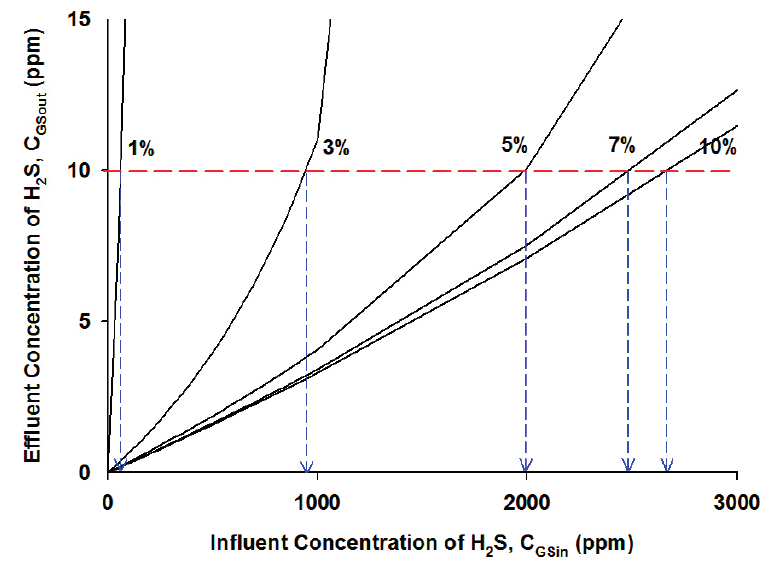
Figure 6. Model simulation results of the H 2 S concentrations at the effluent stream at different influent H 2 S concentrations and oxygen